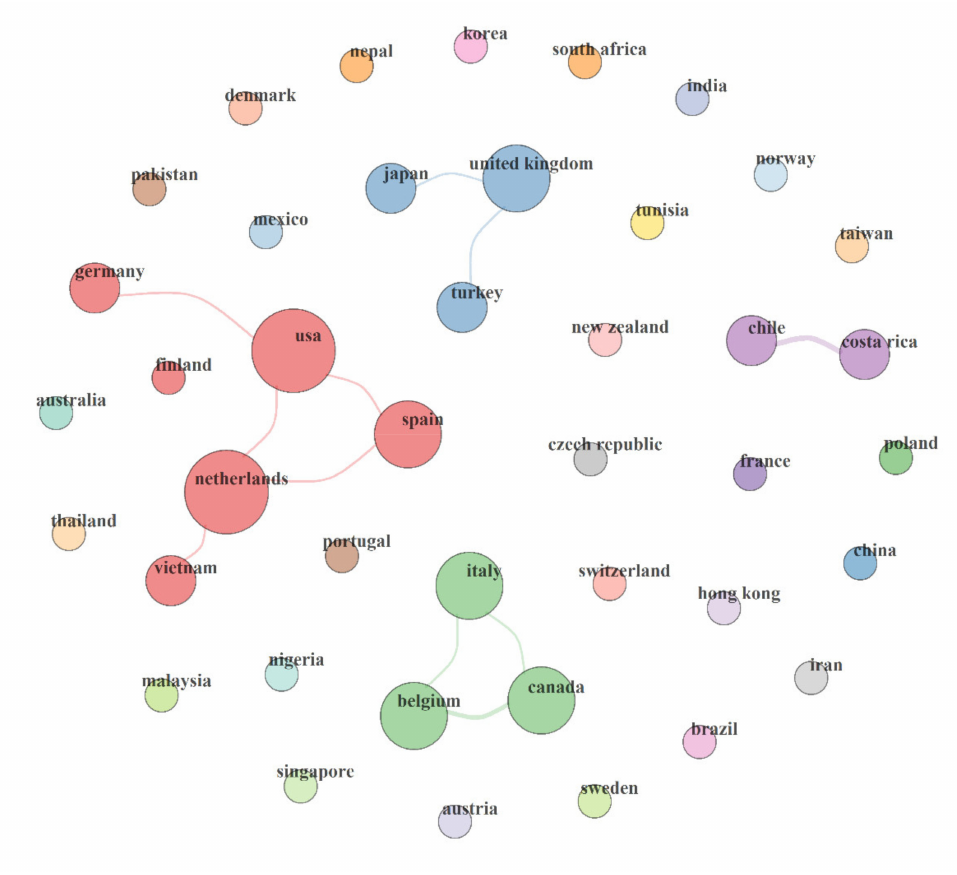
Figure 4. Country’s collaboration